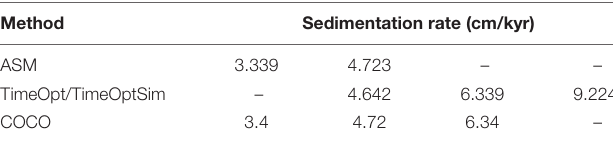
TABLE 3 | Summary of sedimentation rates indicated by the ASM, TimeOpt, and COCO methods.